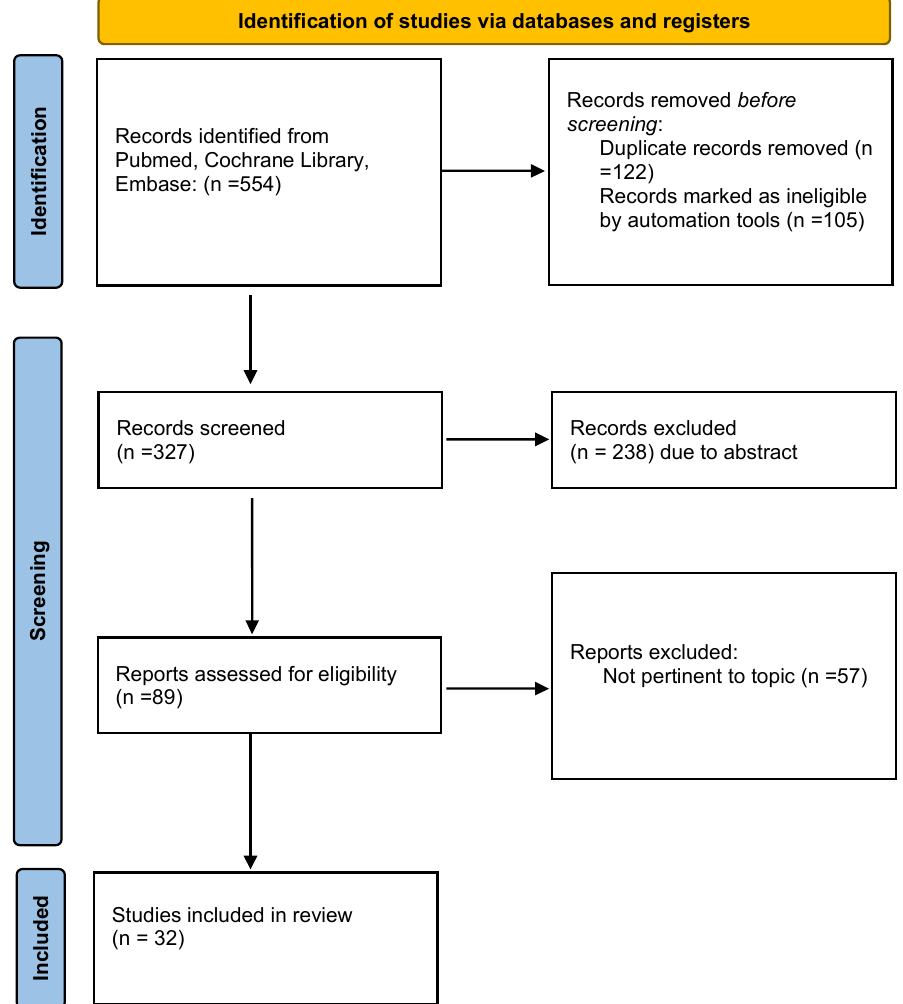
Figure 1. PRISMA flow diagram highlighting paper selection and search strategy.